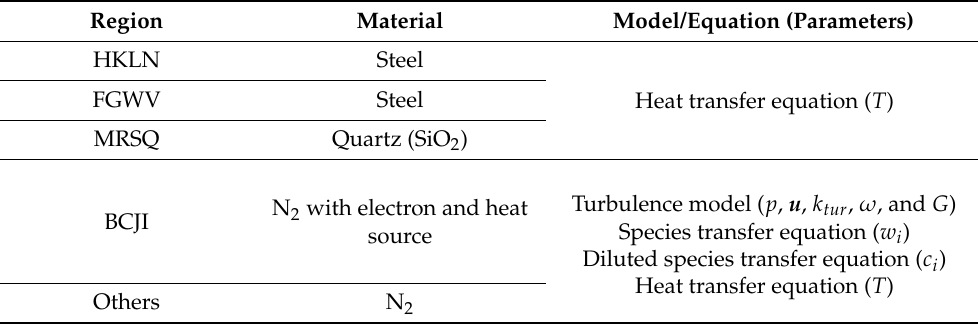
Table 1. Setting of the computing model domains.